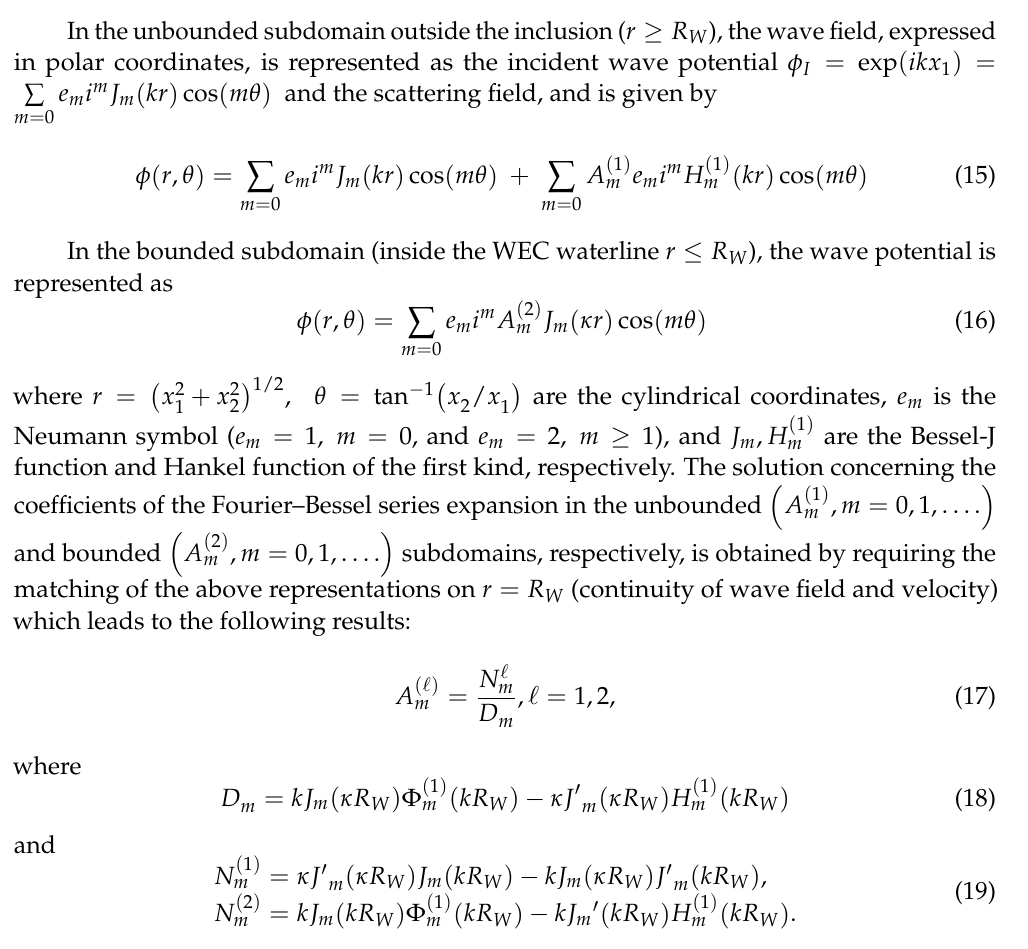
Figure 3. A circular inclusion modelling the absorbing-scattering effect locally of the k